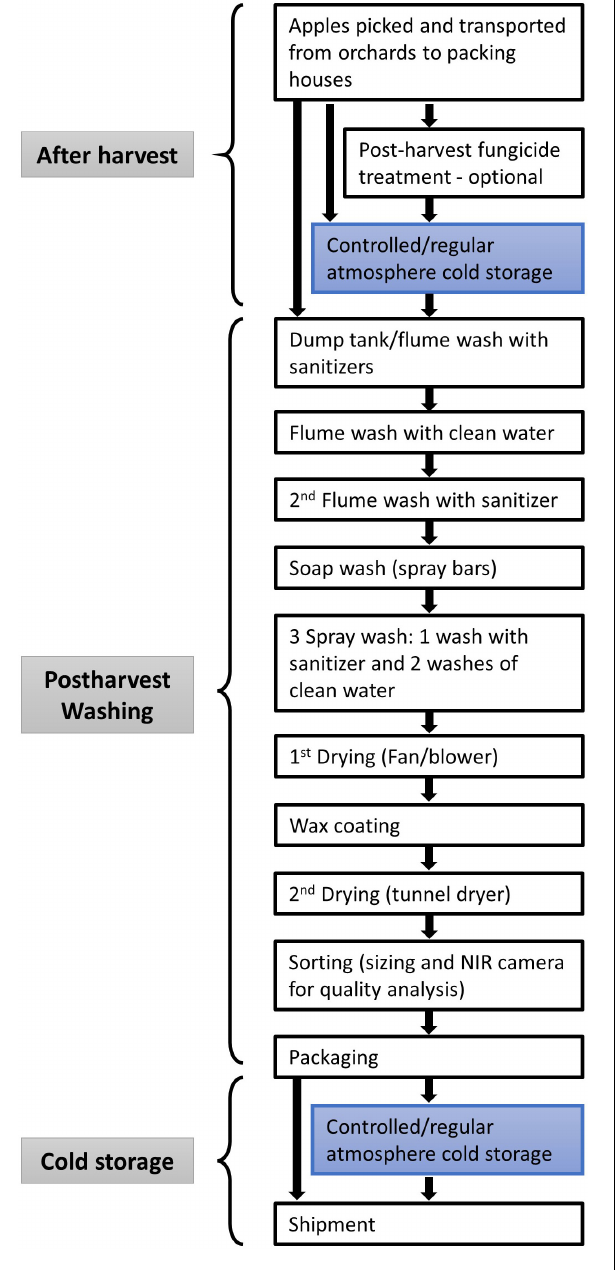
FIGURE 1 | Typical apple packing process in Washington, United States.